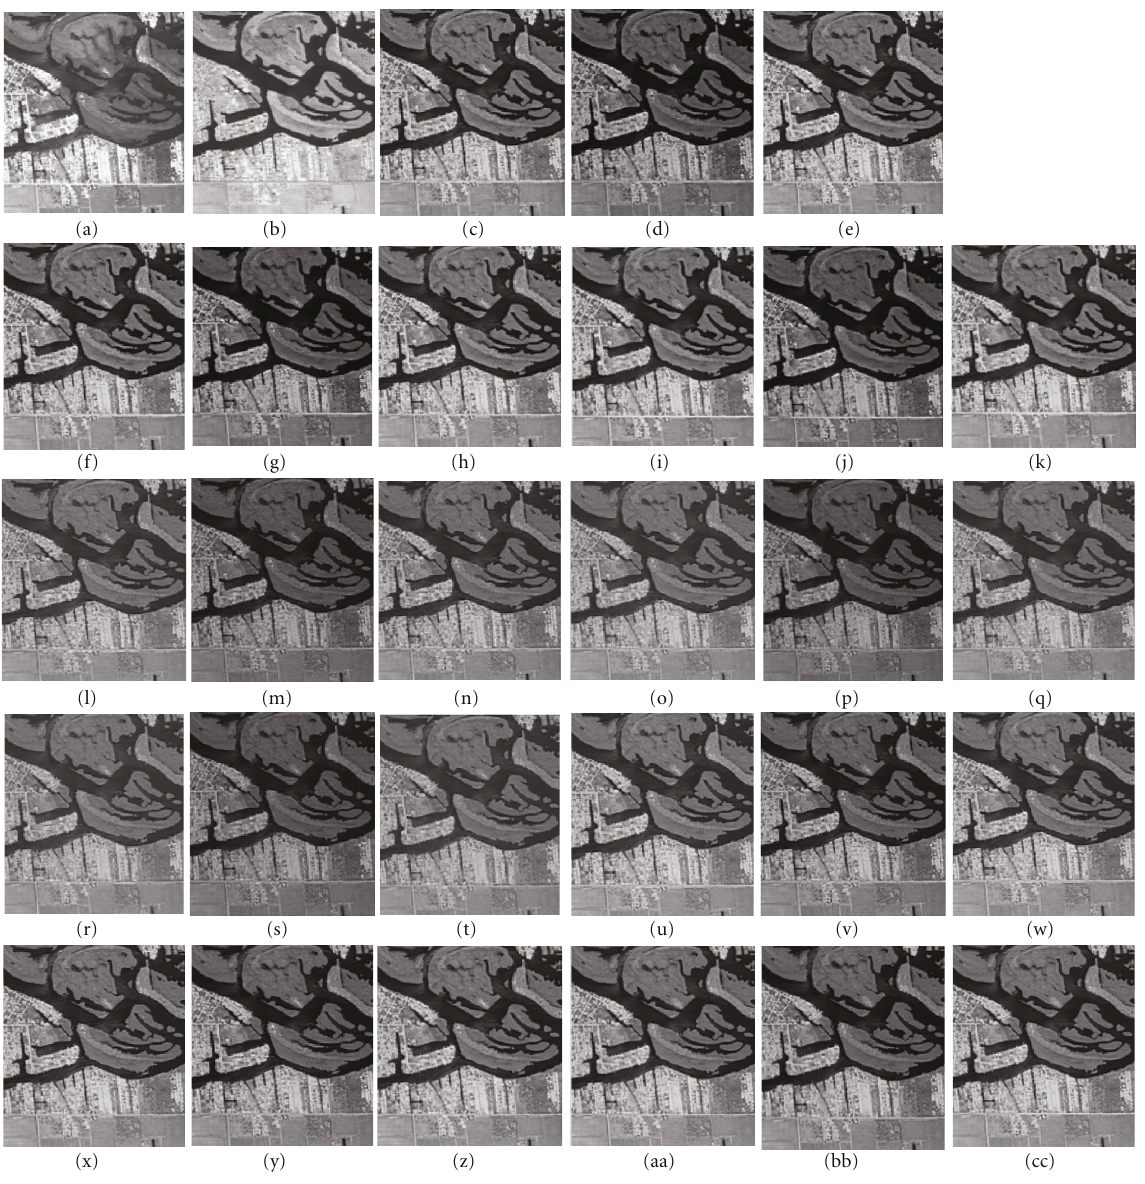
Figure 13: (a) and (b) Original “remote sensing” source images, image fusion results using (c) LP/AM, (d) LIP-LP/AM, (e) PL-LP/AM, (f) LP/BK, (g) LIP-LP/BK, (h) PL-LP/BK, (i) LP/RB, (j) LIP-LP/RB, (k) PL-LP/RB, (l) DWT/AM, (m) LIP-DWT/AM, (n) PL- DWT/AM, (o) DWT/BK, (p) LIP-DWT/BK, (q) PL-DWT/BK, (r) DWT/RB, (s) LIP-DWT/RB, (t) PL-DWT/RB, (u) SWT/AM, (v) LIP-SWT/AM, (w) PL-SWT/AM, (x) SWT/BK, (y) LIP-SWT/BK, (z) PL-SWT /BK, (aa) SWT/RB, (bb) LIP-SWT/RB, (cc)